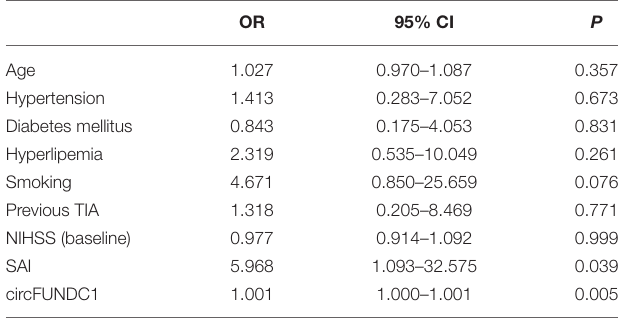
TABLE 2 | Association between circFUNDC1 and early neurological deterioration.